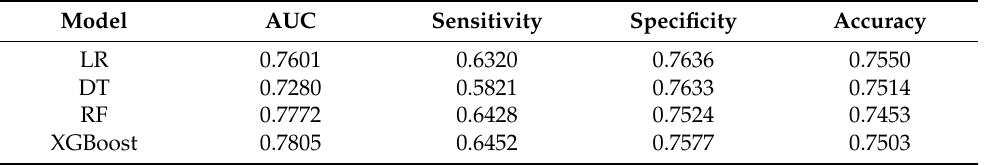
Table 3. Comparison of performance of the four machine learning